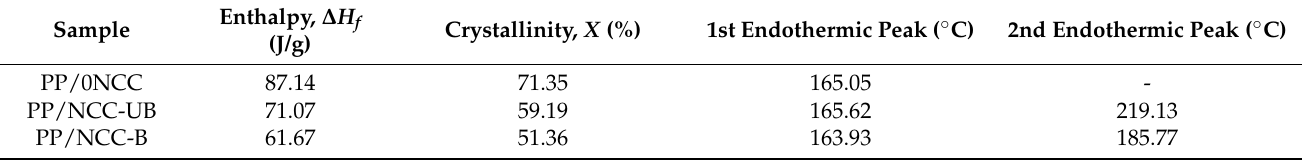
Figure 4. The DSC graph of kenaf core nanocomposites reinforced bleached and unbleached NCC. Table 6. The important differential scanning calorimetry (DSC) values of kenaf core nanocomposites reinforced bleached and unbleached